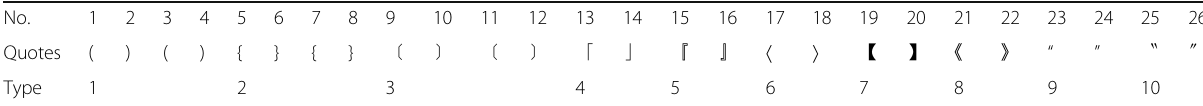
Table 3 Types of Chinese quotation marks